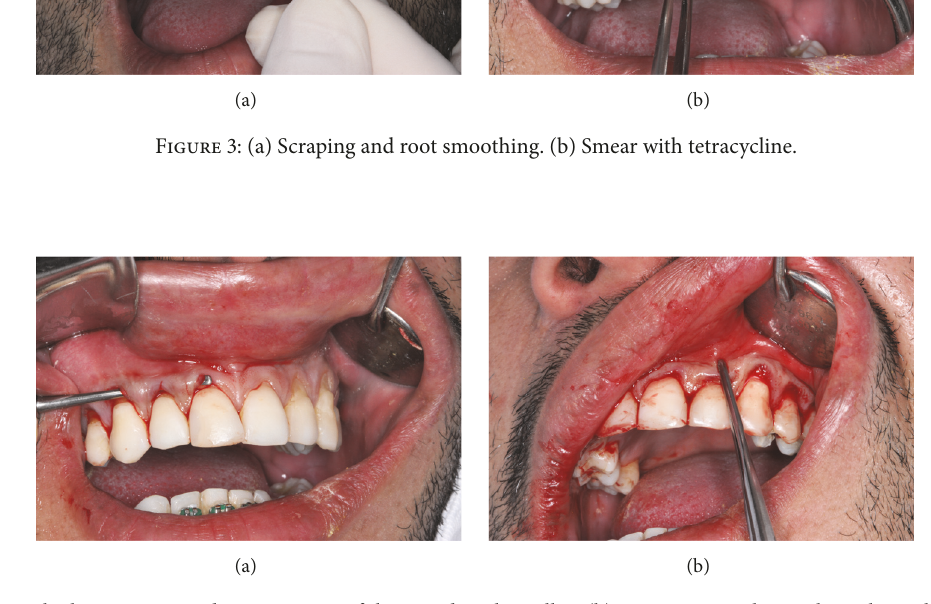
Figure 4: (a) Intrasulcular incisions and conservation of the interdental papillae. (b) Mucoperiosteal tunnel to release the partial thickness